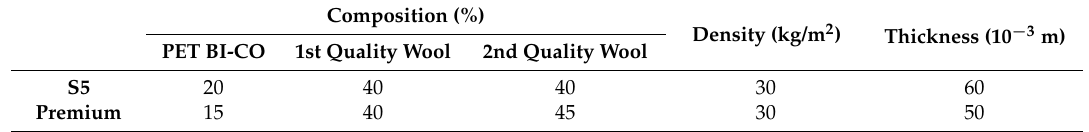
Table 4. Characteristics of some of the evaluated sheep wools in the WOOL4BUILD